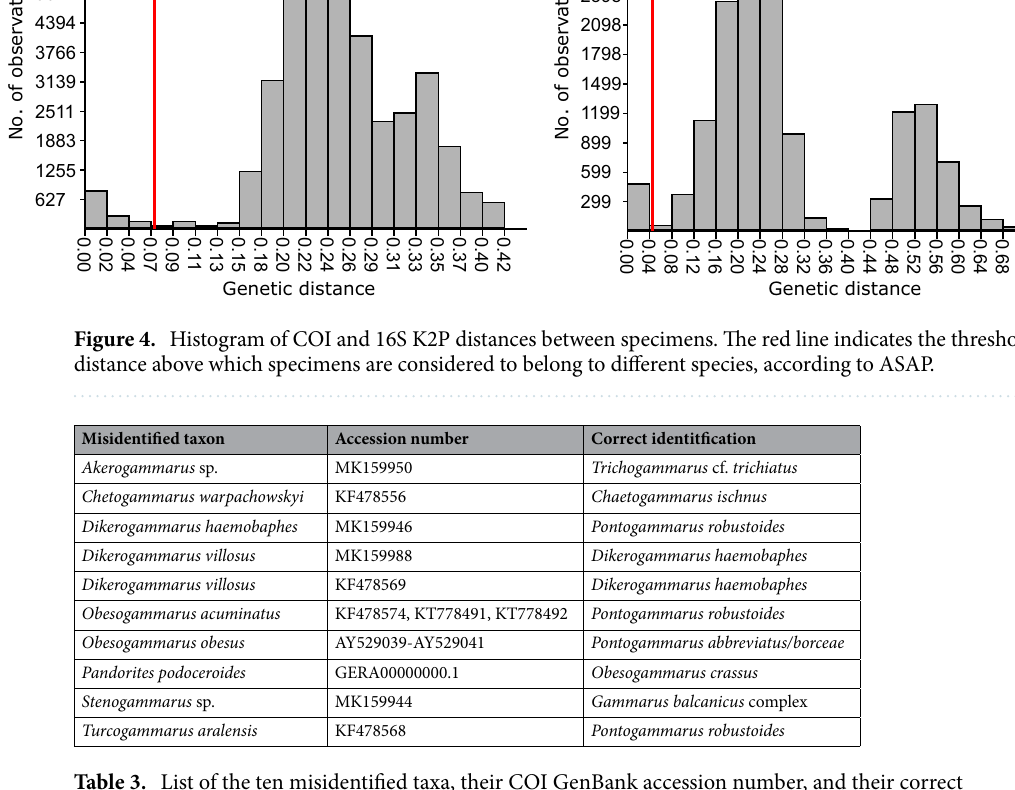
Table 3. List of the ten misidentified taxa, their COI GenBank accession number, and their correct identifications.